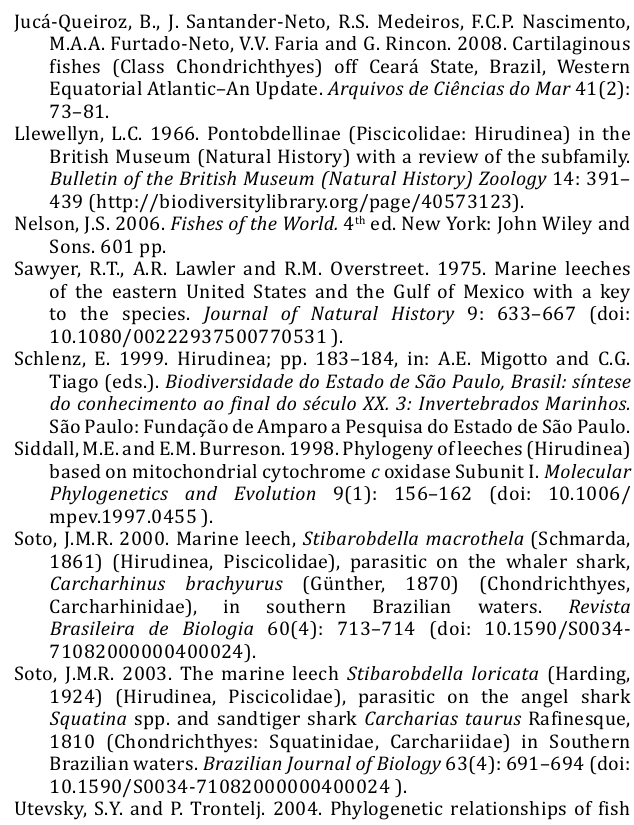
São Paulo: Fundação de Amparo a Pesquisa do Estado de São Paulo. Siddall, M.E. and E.M. Burreson. 1998. Phylogeny of leeches (Hirudinea) Phylogenetics and Evolution based on mitochondrial cytochrome